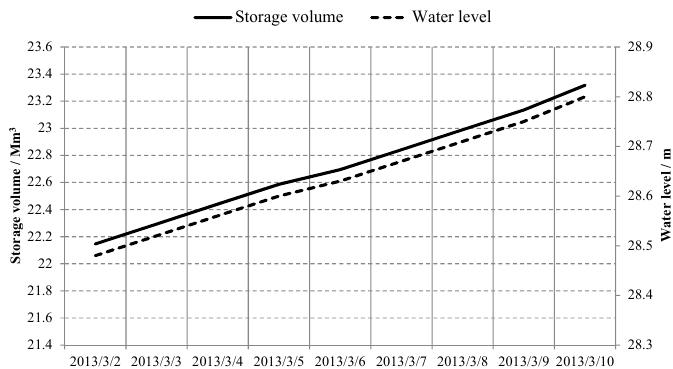
Figure 9. The water level process of the Xili reservoir during the operation.